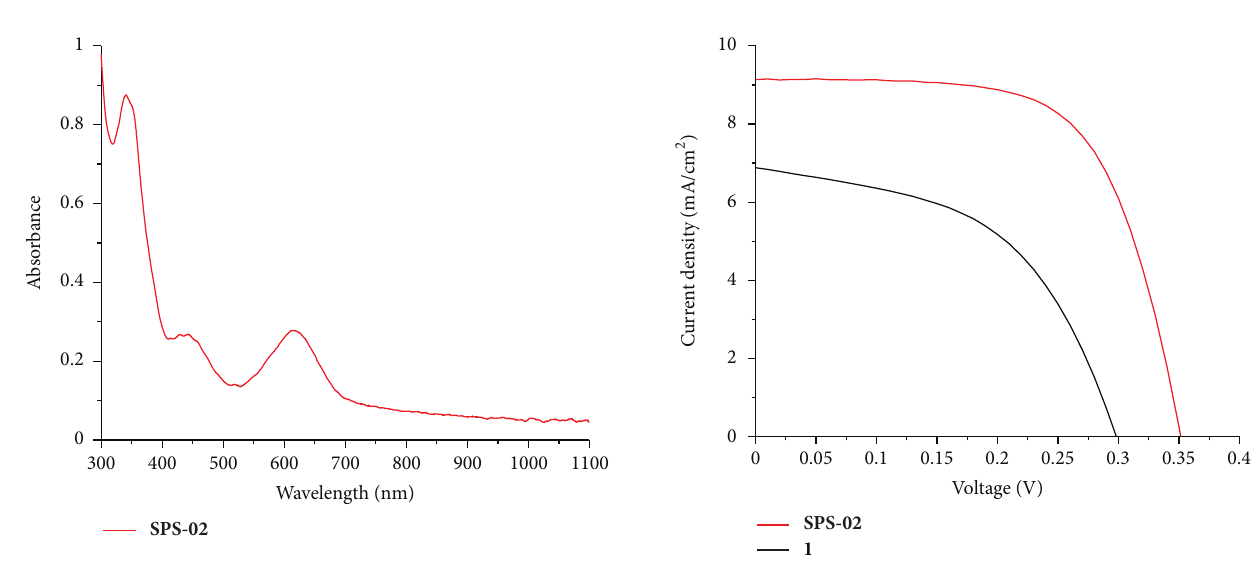
F 2: UV absorption spectra of SPS-02 in ethanol.